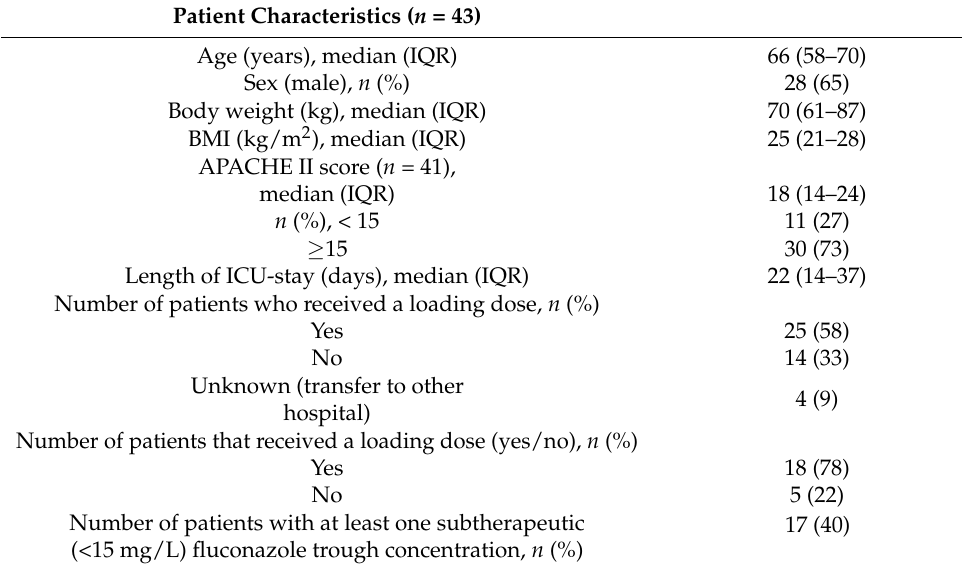
Table 1. Demographics, sample information, and